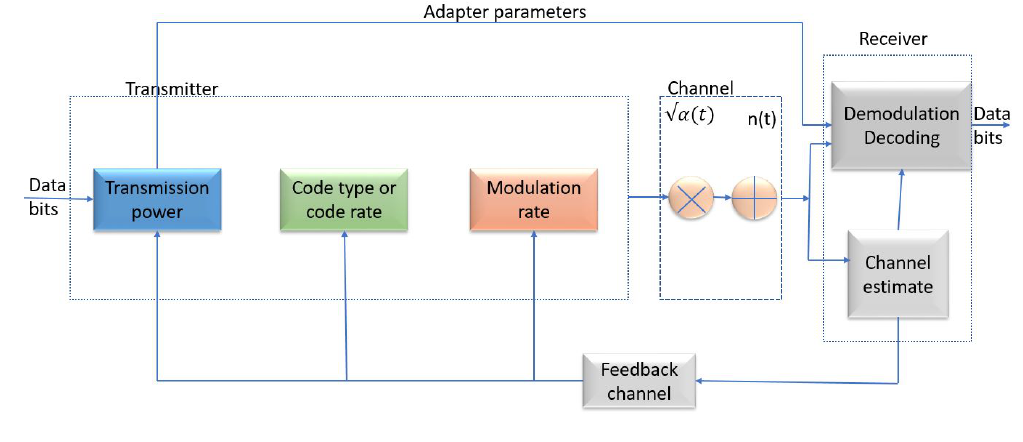
Figure 6. Channel adaptive